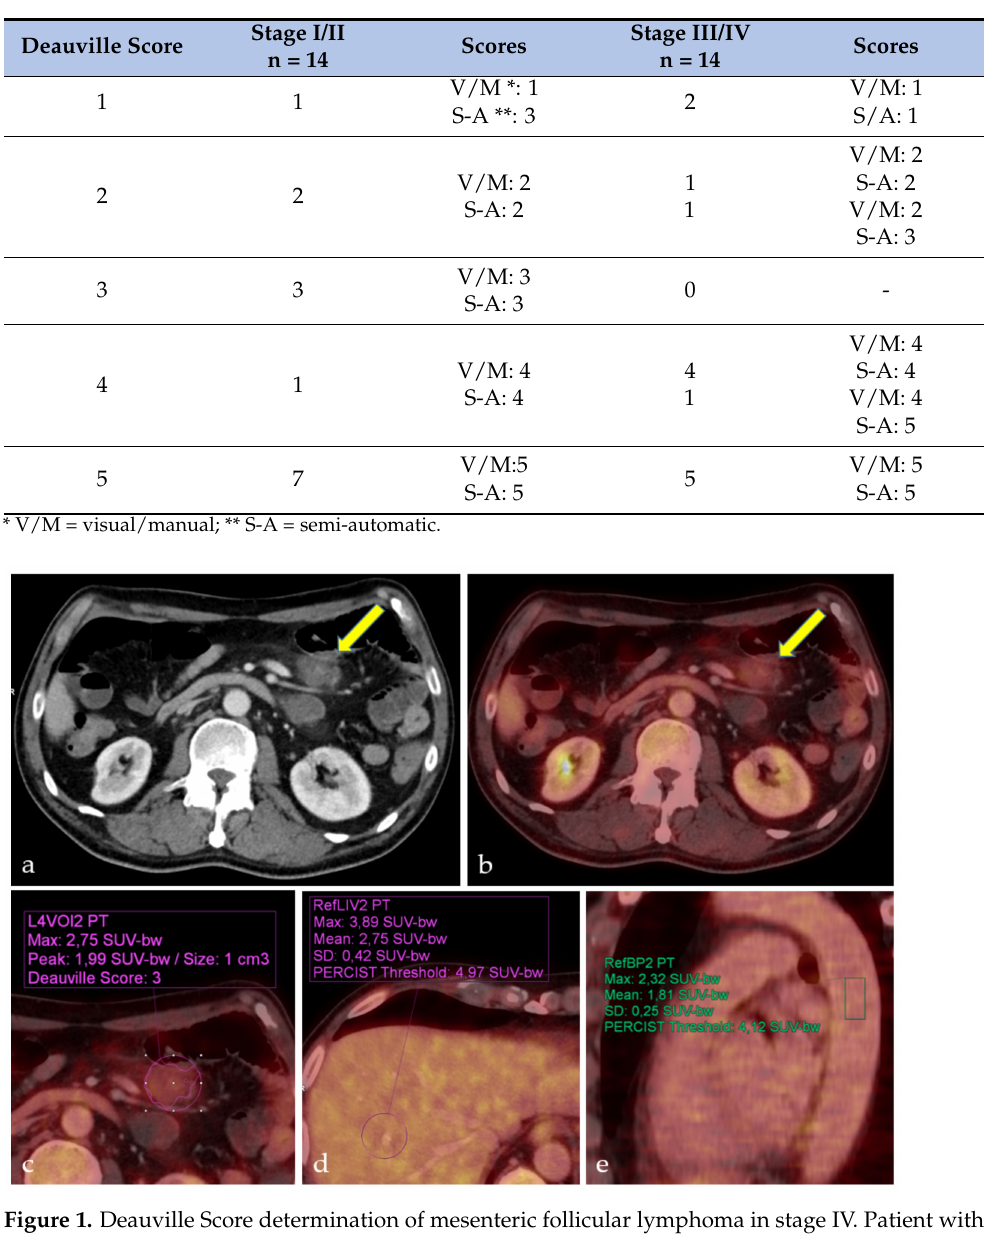
Table 4. Visual/manual versus semi-automatic DS.